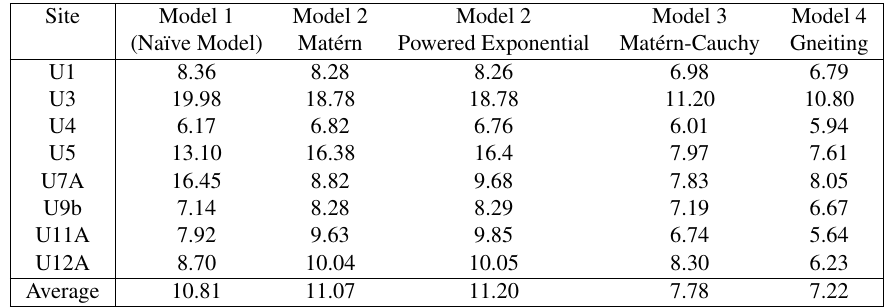
Table 3. PRMSE for Models